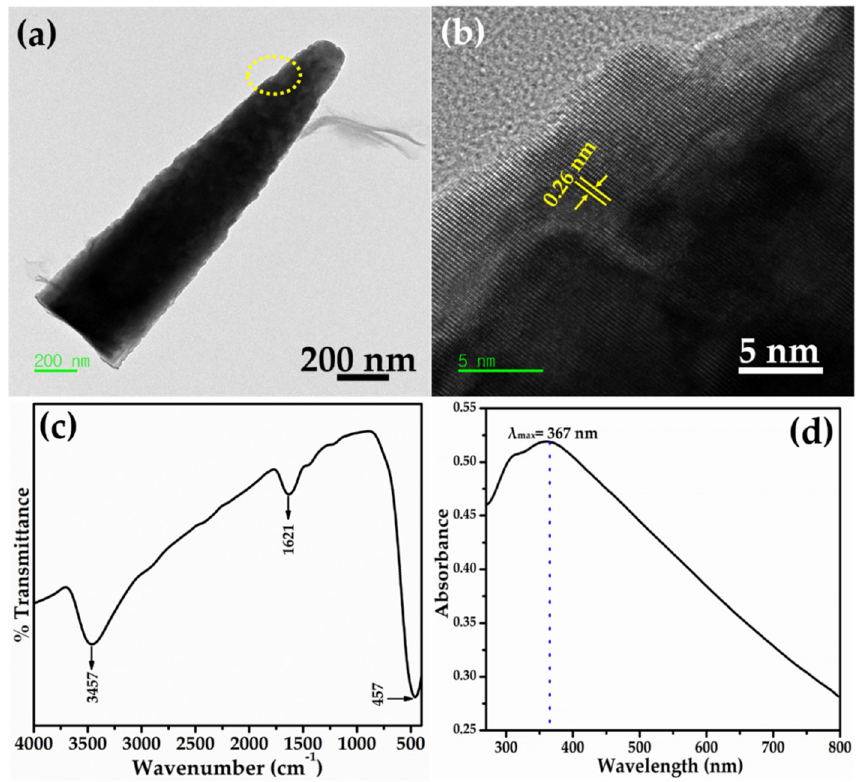
Figure 4. ( a ) HR-TEM image, ( b ) lattice fringes, ( c , d ) FTIR and UV-visible spectra of